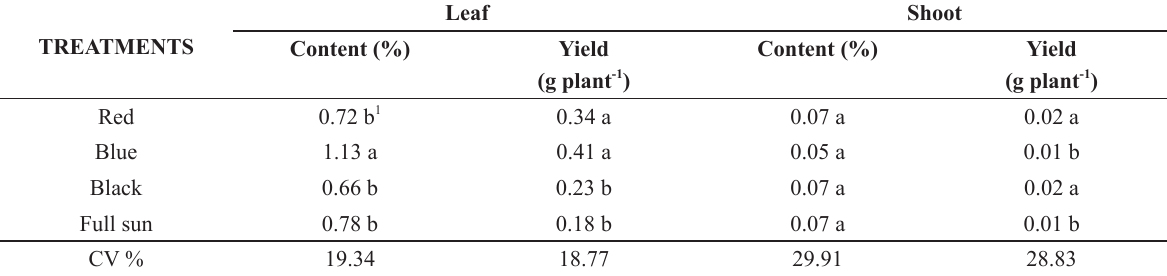
Essential oil content and yield of P. cablin leaves and shoot grown under full sun and under colored shade nets.